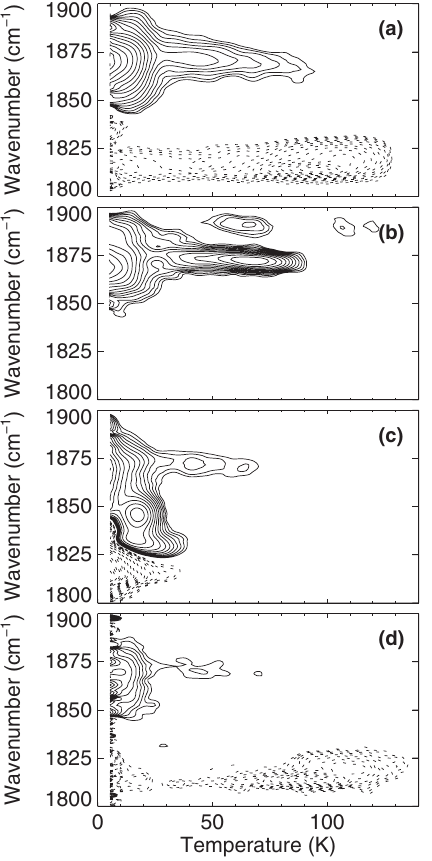
Figure 6. TDS contour maps of iNOS -NO, obtained after 30-min oxy illumination at 4 K. iNOS -NO ( a ) w/o substrate; ( b ) with H4B; ( c ) oxy with L-Arg; ( d ) with NOHA. Contours are spaced logarithmically; solid and dotted lines represent increasing and decreasing absorption,